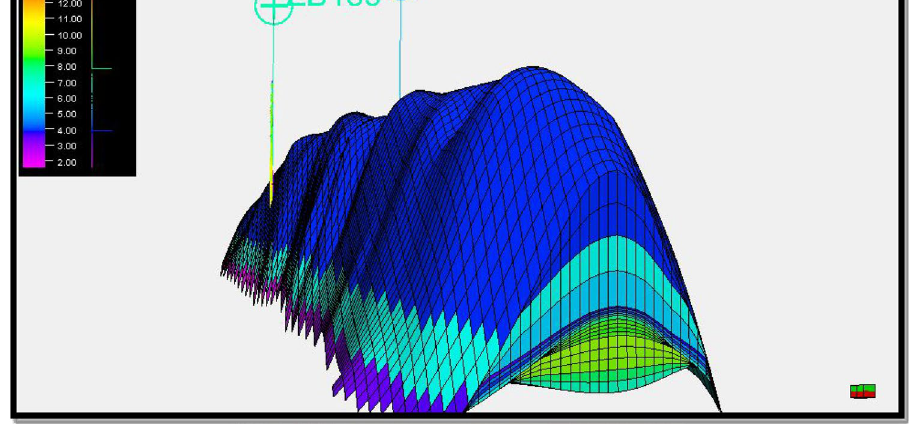
Fig. 19 Tensile strength